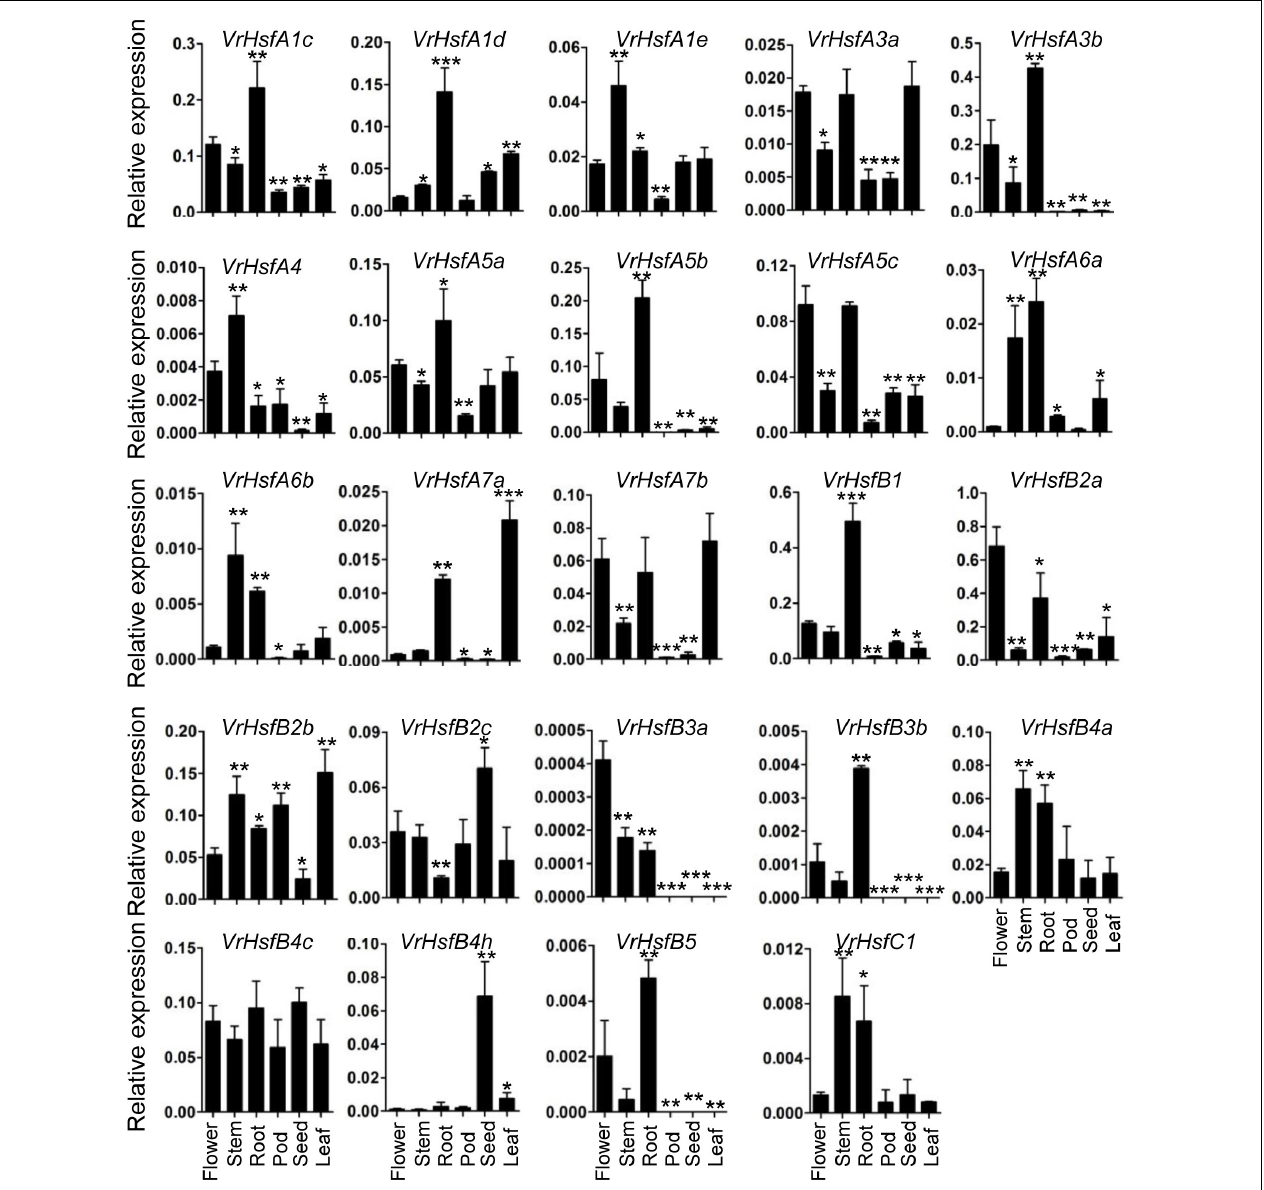
FIGURE 6 | Expression analysis of VrHsf genes in different tissues. Tissues, such as flower, stem, root, leaf pod and seed were used for analysis. Each sample was analyzed using three biological replicates and normalized to an Actin -expressing gene in mungbean ( Vradi03g00210 ). ∗∗∗ , ∗∗ , and ∗ are significantly different at P < 0.001, P < 0.01, and P < 0.05, respectively, compared with